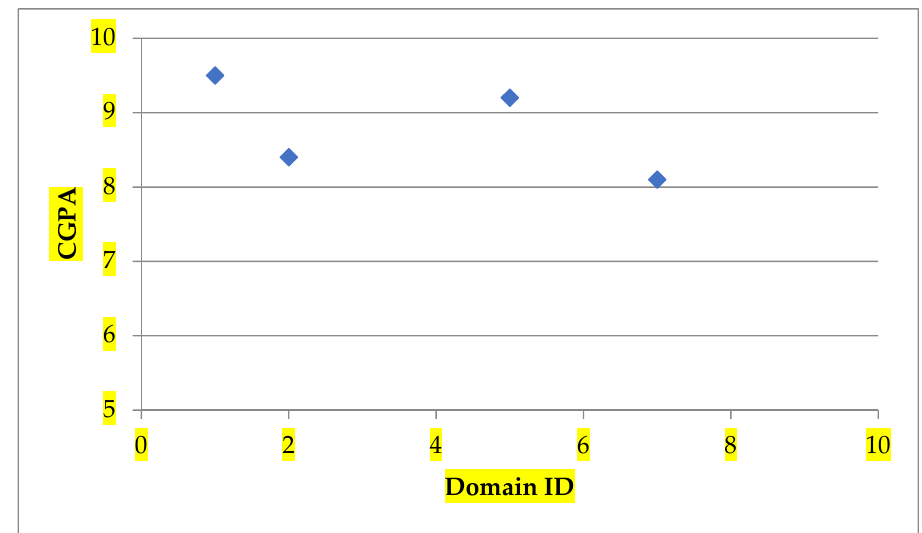
Figure 5. Identification of domain expertise of a student s . Algorithm 3: Elective Course Recommendation